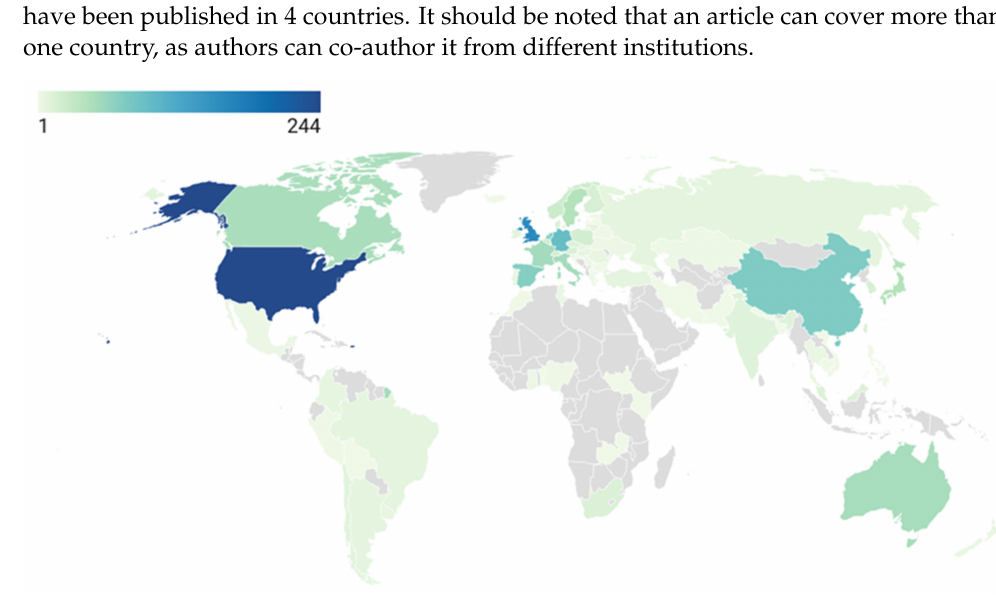
Figure 4. Worldwide publications on pension research. Source: own elaboration. The most prolific country is the U.S.A., with 18.95% of publications (244 articles), followed by the U.K. with 12.43% (160 articles), and Germany with 7.38% (95 articles). China and Spain are in fourth and fifth place with 76 and 72 articles, respectively. Table 5 also shows how this higher publication of articles by country does not correspond to the position in terms of the citations per article received. Thus, in this case, although the U.S.A. is still first, the second position is occupied by Germany and the third by the U.K., with the Netherlands and Australia also standing out among the top five countries in terms of citations per